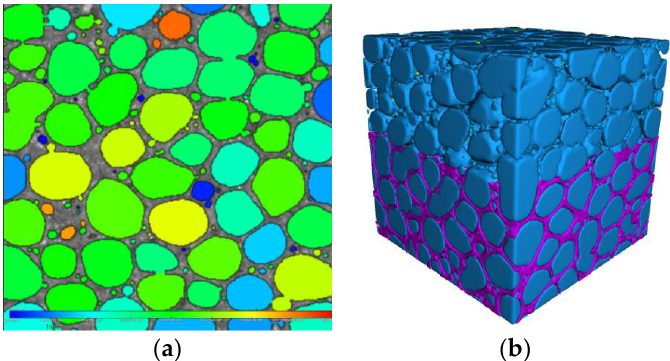
Figure 10. Micro-CT reconstruction graph: ( a ) 2D structure diagram; ( b ) 3D structure diagram.